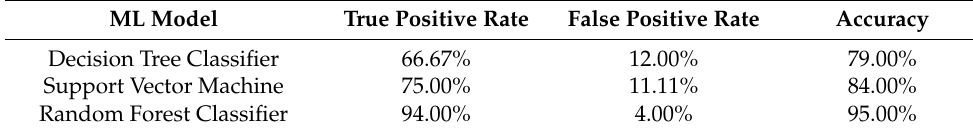
Table 5. Accuracy, TPR, and FPR of machine learning model experiments.